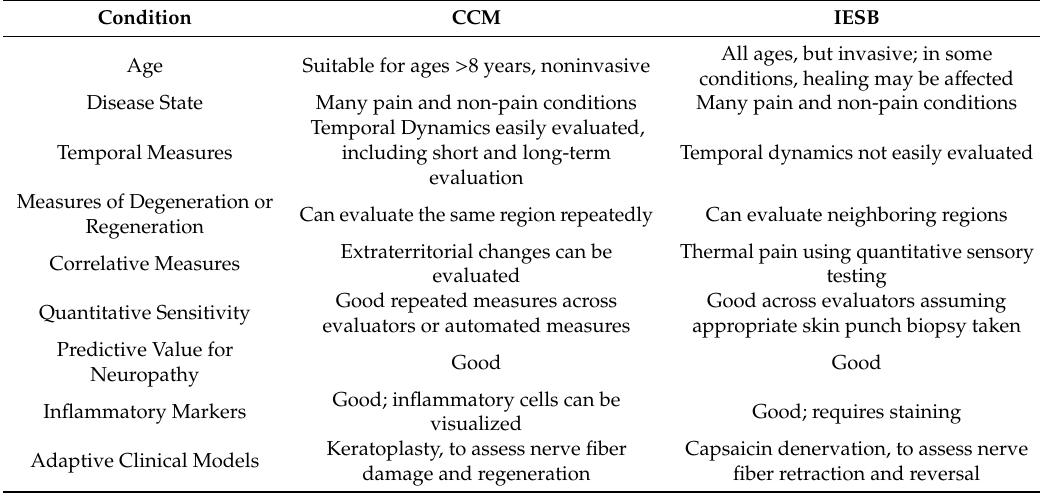
Table 2. Relative advantages of CCM vs. IESB in evaluating C-fiber changes.